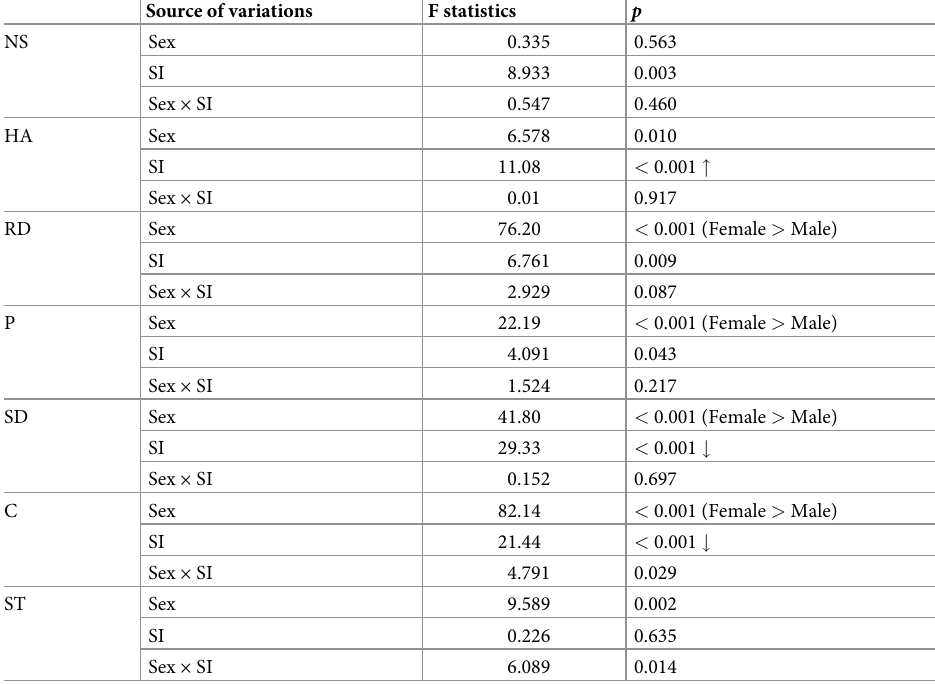
Table 5. Comparison of TCI scores using a two-way ANOVA among non-SI and